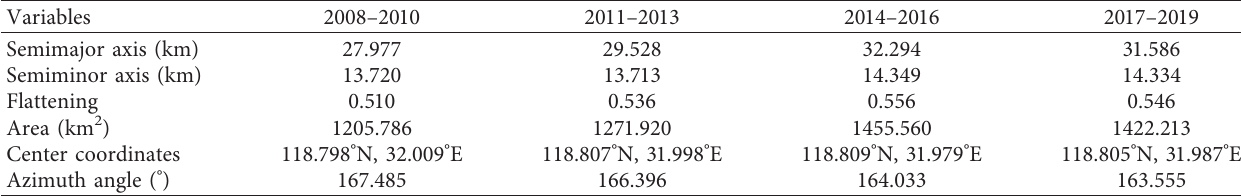
Table 4: Results of standard deviational ellipse.